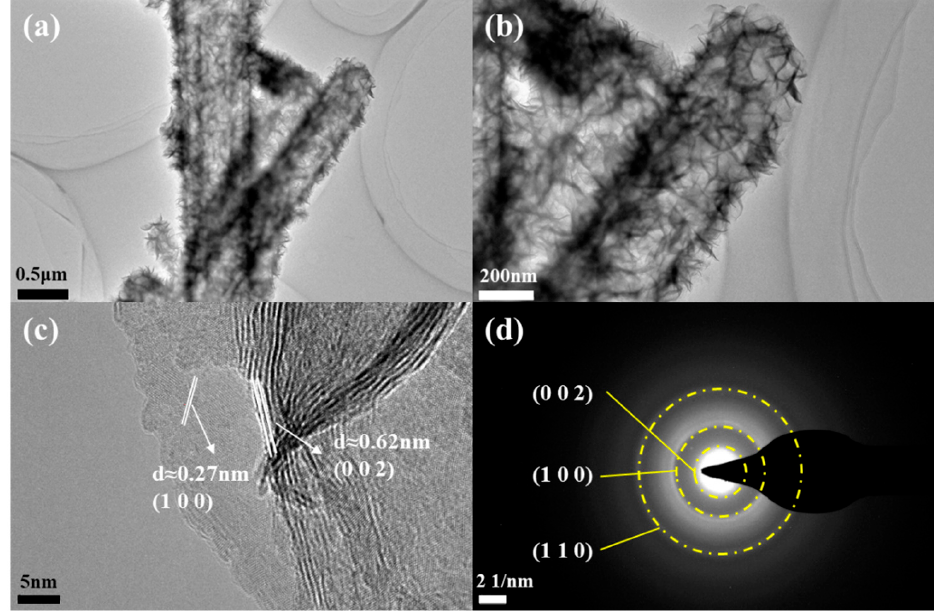
Figure 4. ( a , b ) TEM images, ( c ) HRTEM, and ( d ) SAED pattern of FR-MoS 2 /PPy.